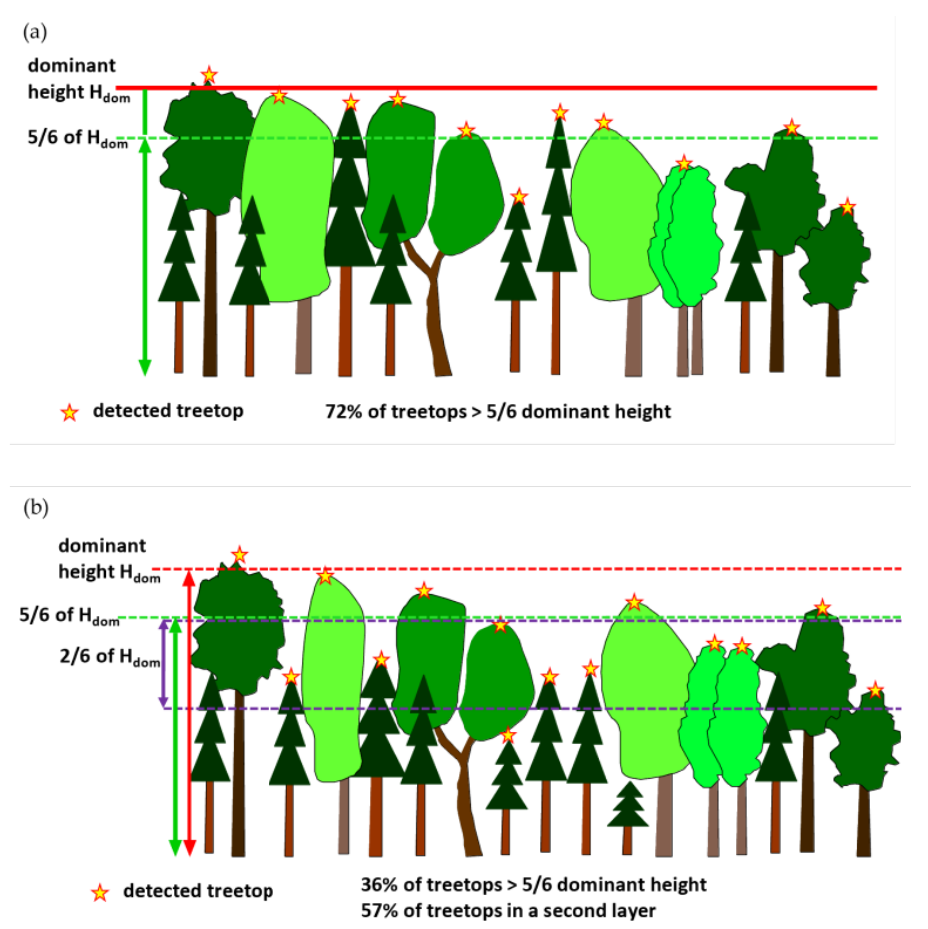
Figure 5. Schematic illustration of the original EBA approach based on individual detected treetops. ( a ) is an example of a one-layered stand: 8 (72%) out of 11 detected treetops denoted as stars lie in the upper 1 ⁄ 6 of the dominant height. ( b ) is an example of a two-layered stand: 5 (36%) out of 14 detected treetops are in the upper 1 ⁄ 6 of the dominant height and 8 (57%) of the detected treetops reside in another layer. This approach was adapted to work with amplitude/returns instead of treetops.